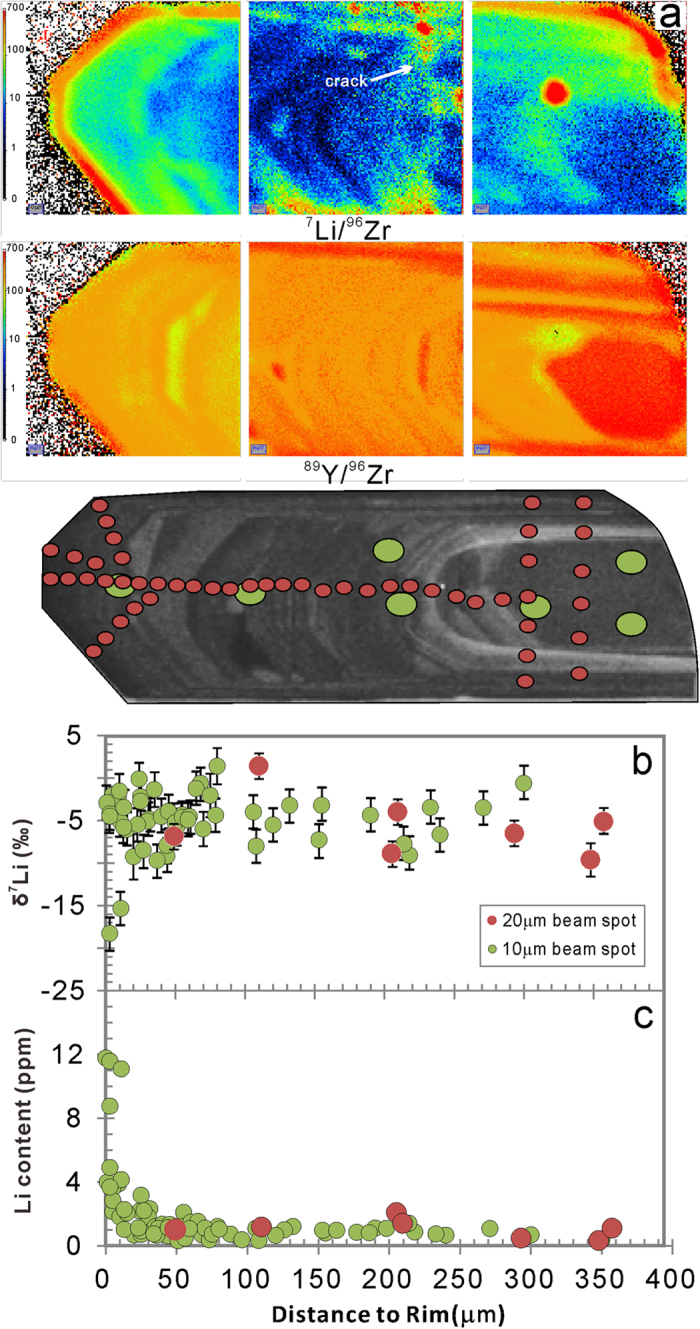
(a) Ion image of the variation of Li, Y content and CL image of the Qinghu zircon. (b) δ7Li vs relative distance to the rim. (c) [Li] vs relative distance to the rim.